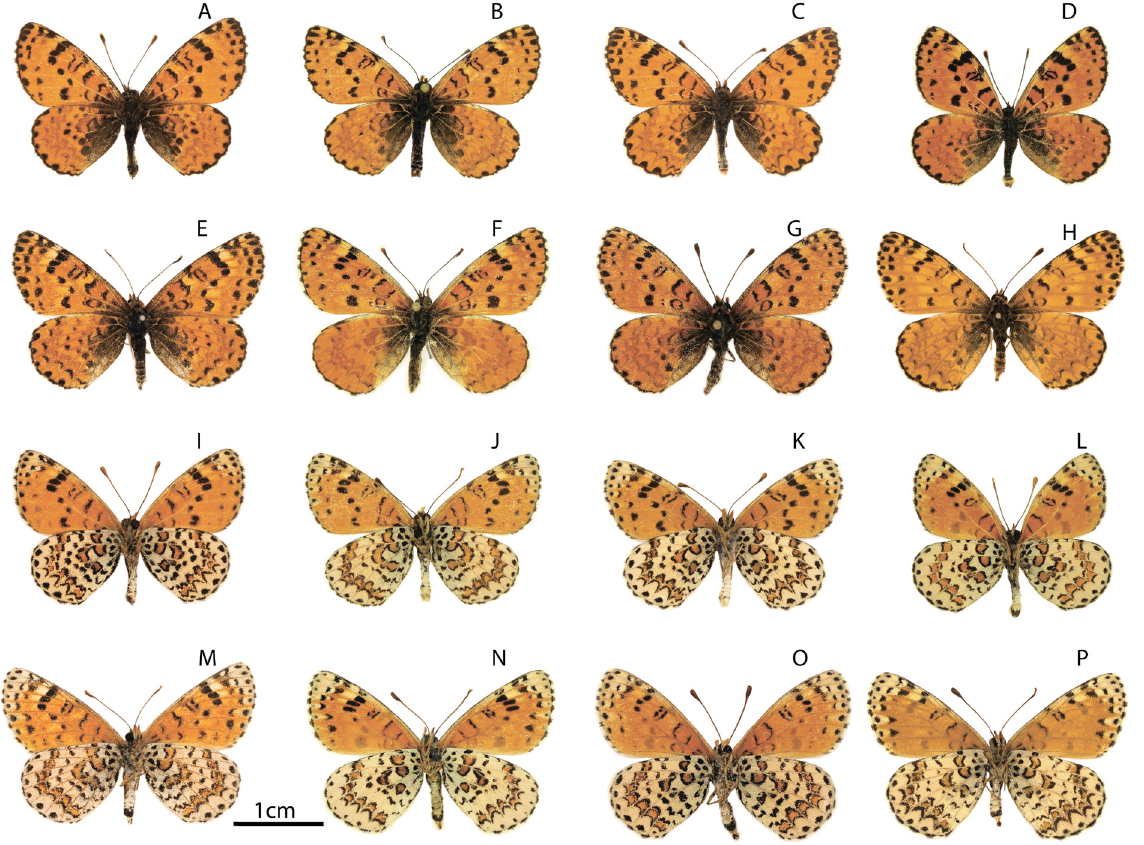
Fig. 21. Adults of Melitaea shahvarica sp. nov. A–H . UPS. I – P . UNS. A, I . Holotype, ♂ (SDM). B–H